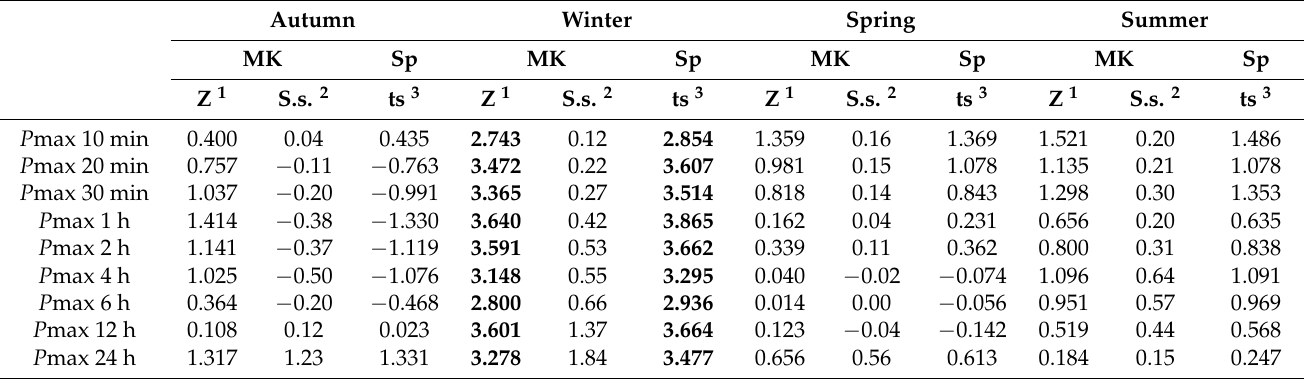
Table 3. Values of the Mann–Kendall and Spearman statistics for all the maximum seasonal precipitation intensities.